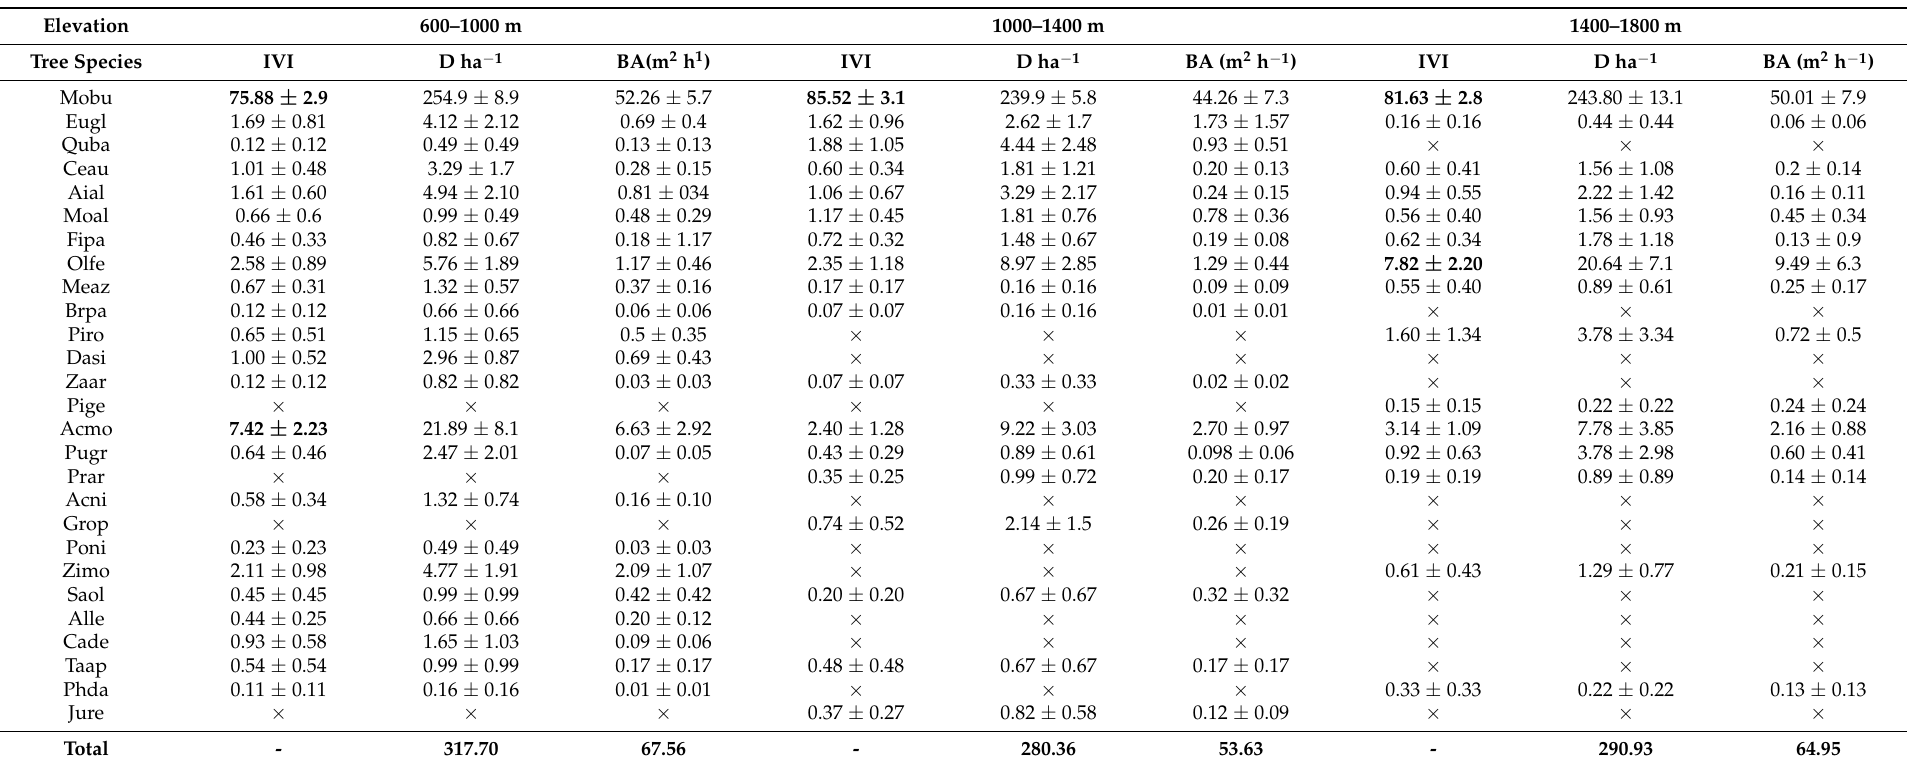
Table 1. Mean importance values indices (IVI), stem density ha − 1 (D. ha − 1 ) and Basal area m 2 ha − 1 (BA) of the tree species for Monotheca dominated forests across different elevation ranges in